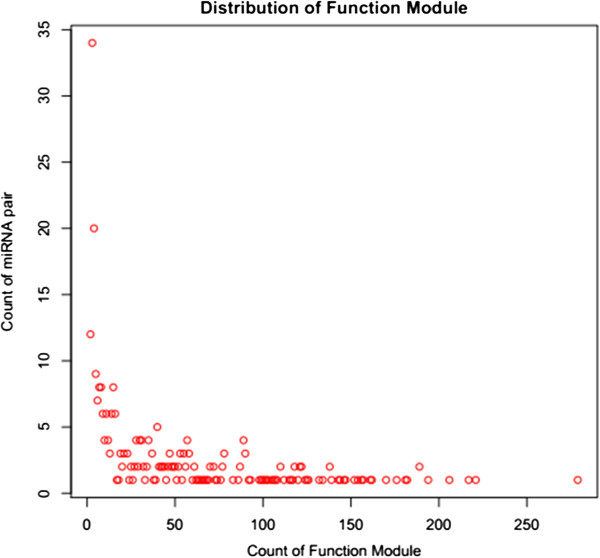
Distributions of function modules of synergistic miRNA pairs. Horizontal axis represents the count of function module, while vertical axis represents the count of the miRNA pairs.